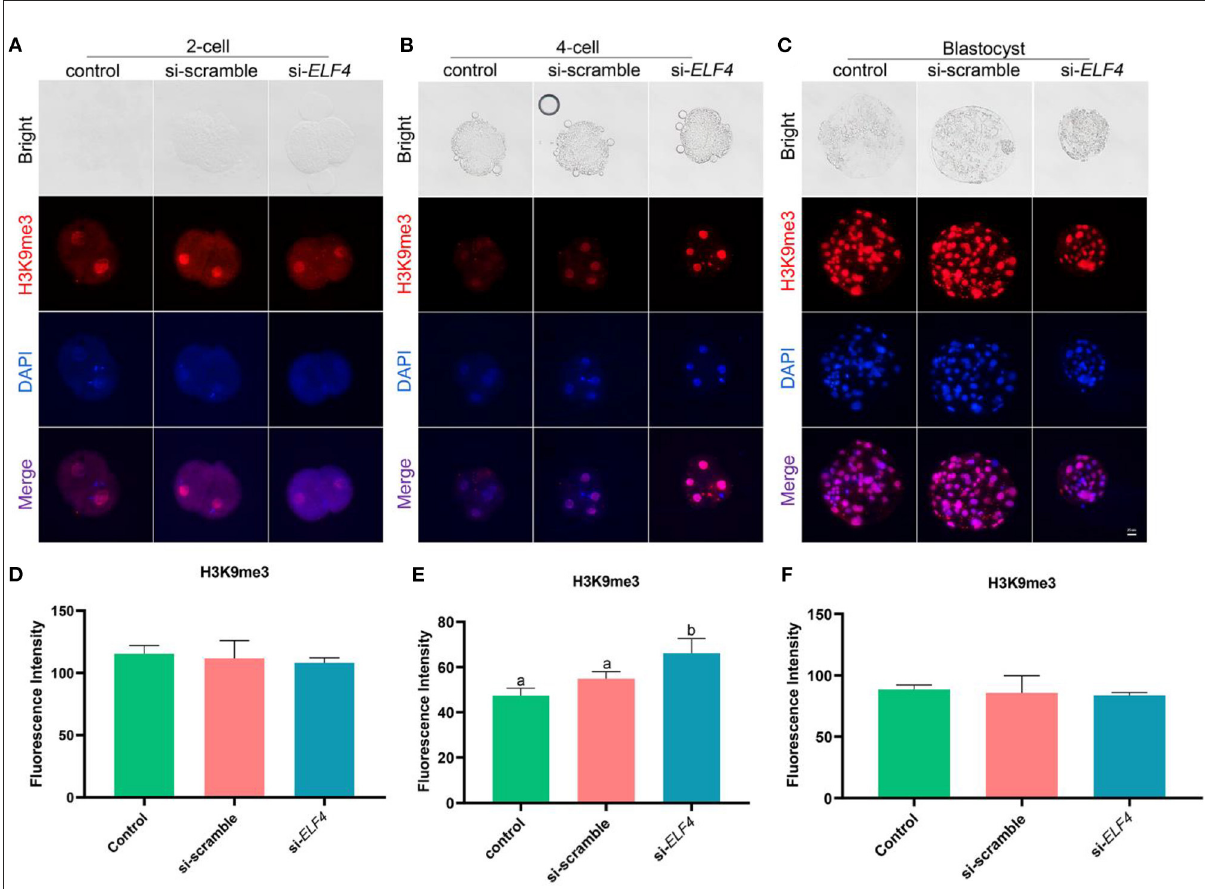
FIGURE6 Dynamic changes of H3K9me3 at different stages of preimplantation IVF development after ELF4 knockdown. (A–C) Immunofluorescence staining of H3K9me3 in the control, si-scramble, and si- ELF4 embryos. Scale bars represented 25 µ m. (D–F) Semi-quantitative fluorescence intensity analysis of the H3K9me3 staining. Different lowercase letters indicate statistical differences ( p <